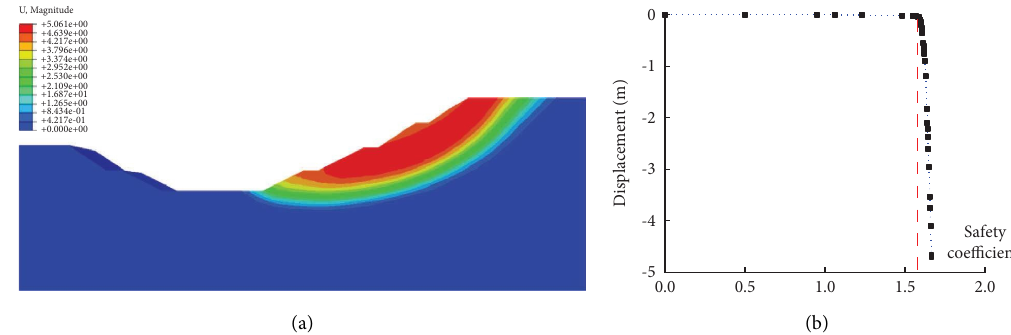
Figure 8: Displacement and safety factor under conventional working conditions. (a) Displacement nephogram; (b) stability safety factor. PEEQ (Avg: 75%) +1.390e+00 +2.800e+00